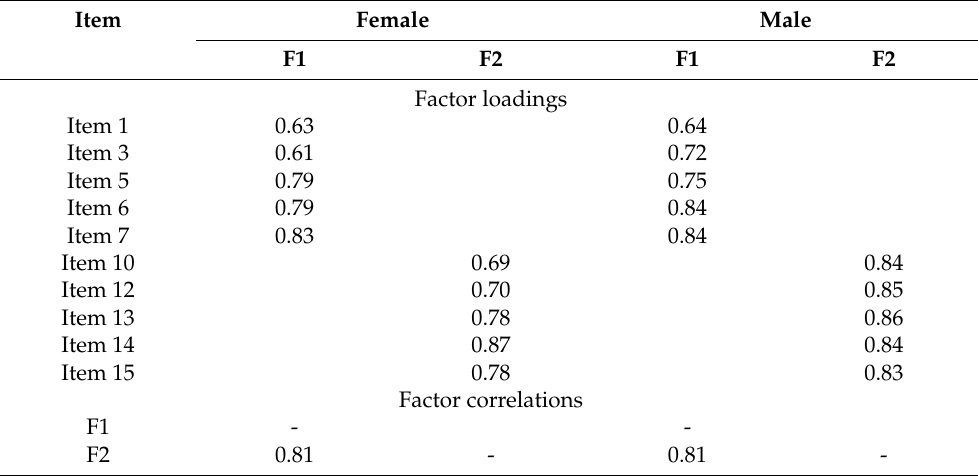
Table 7. Standardized solutions for the confirmatory factor analyses for both samples.